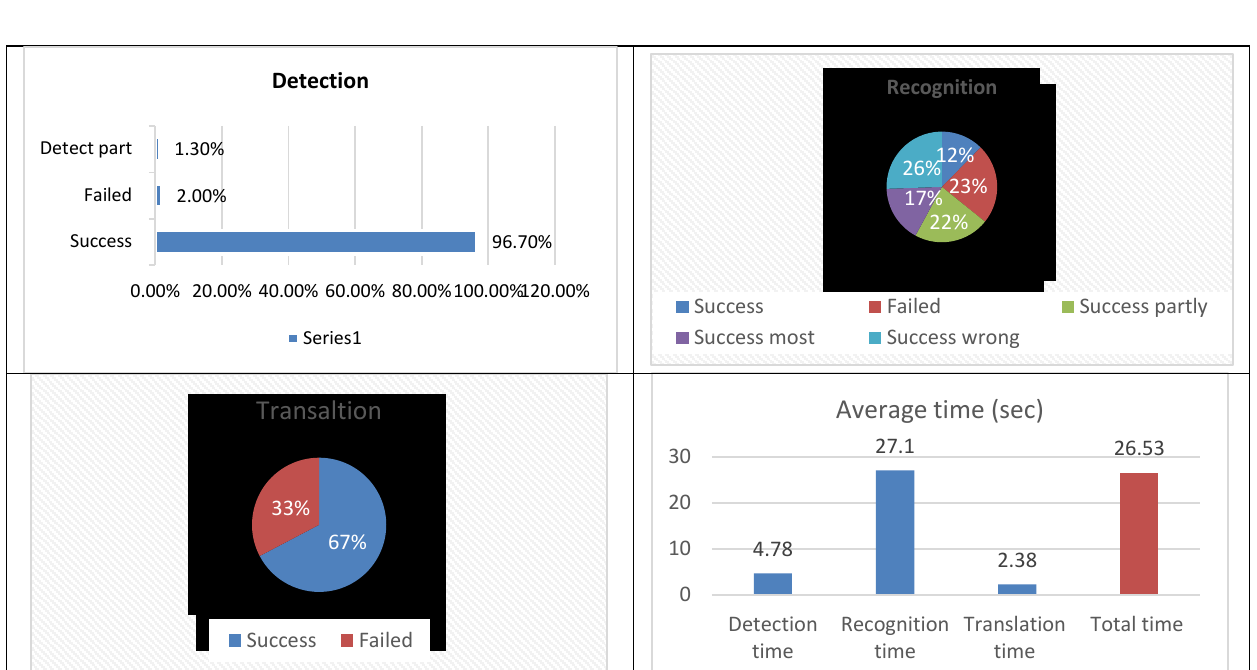
Fig. 7. ALIF dataset testing results